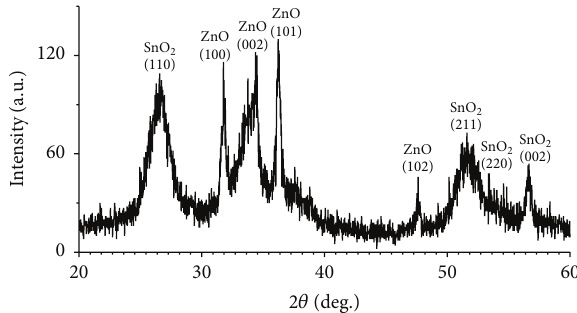
Figure 1: XRD spectrum for SnO 2 /ZnO composite system.